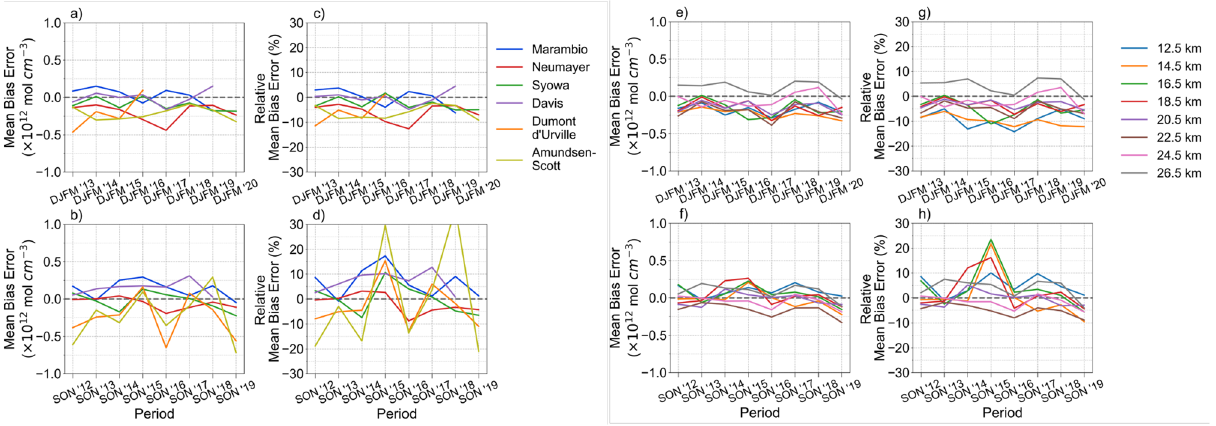
Figure 4. Time series of the absolute and relative mean bias errors ( MBE ) of OMPS-LP-derived estimates of the ozone (relative to balloon-borne data) computed over the DJFM period (first row) and over the SON period (second row). ( a – d ) per station; ( e – h ) per altitude. Plots were generated by using Python’s Matplotlib Library 63